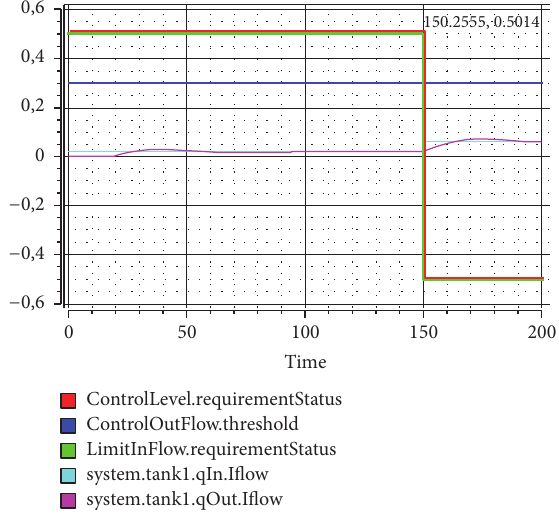
Figure 5: After 150 seconds, the status of ControlLevel and Limit- InFlow requirements changes to